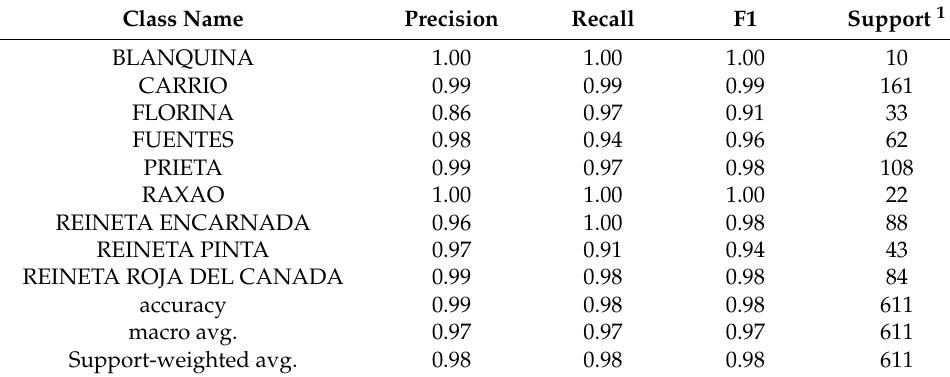
Table 5. Class metrics for the InceptionV3 trained